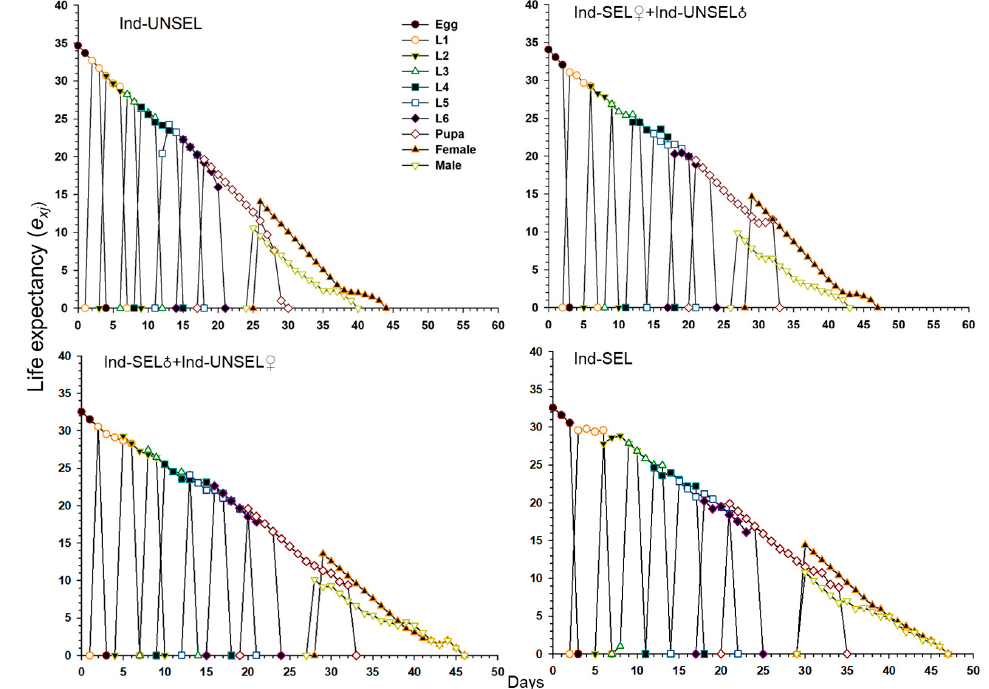
Figure 5. Age-Stage specific reproductive value ( v xj ) of Ind-UNSEL, Ind-SEL ♀ × Ind-UNSEL ♂ , Ind-SEL ♂ × Ind-UNSEL ♀ and Ind-SEL population of S. frugiperda.